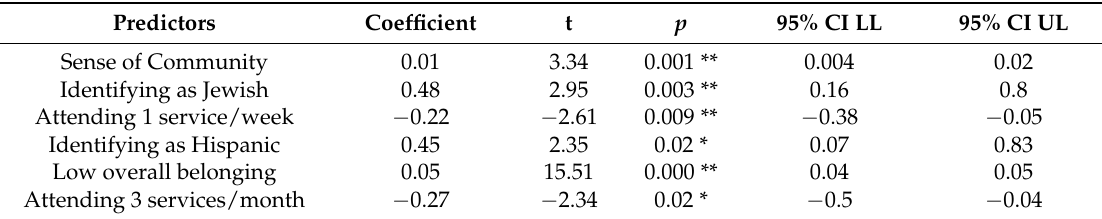
Table 2. Predictors of suicidal